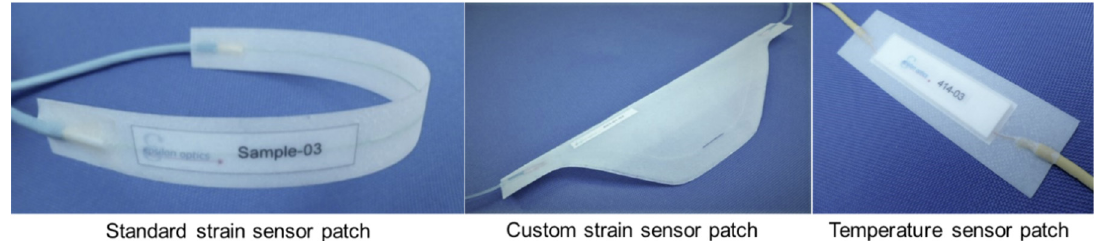
Figure 2. Surface bonded sensor patch (courtesy: Epsilon Optics).